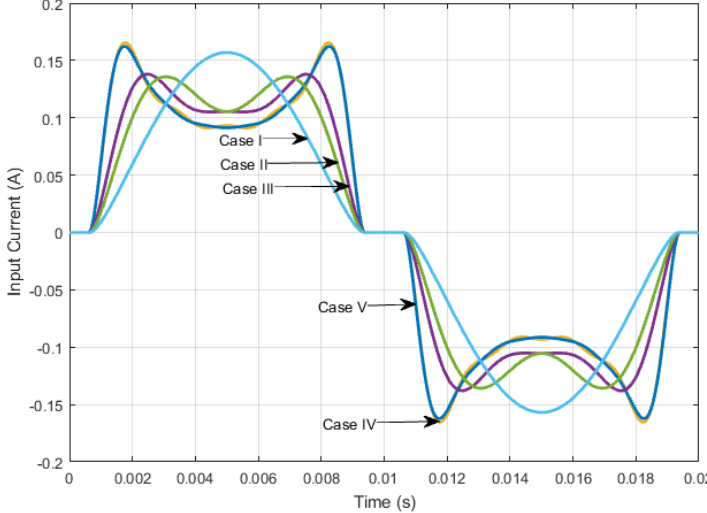
Figure 8. The LED current waveforms under different harmonics order combinations at 220 V in .